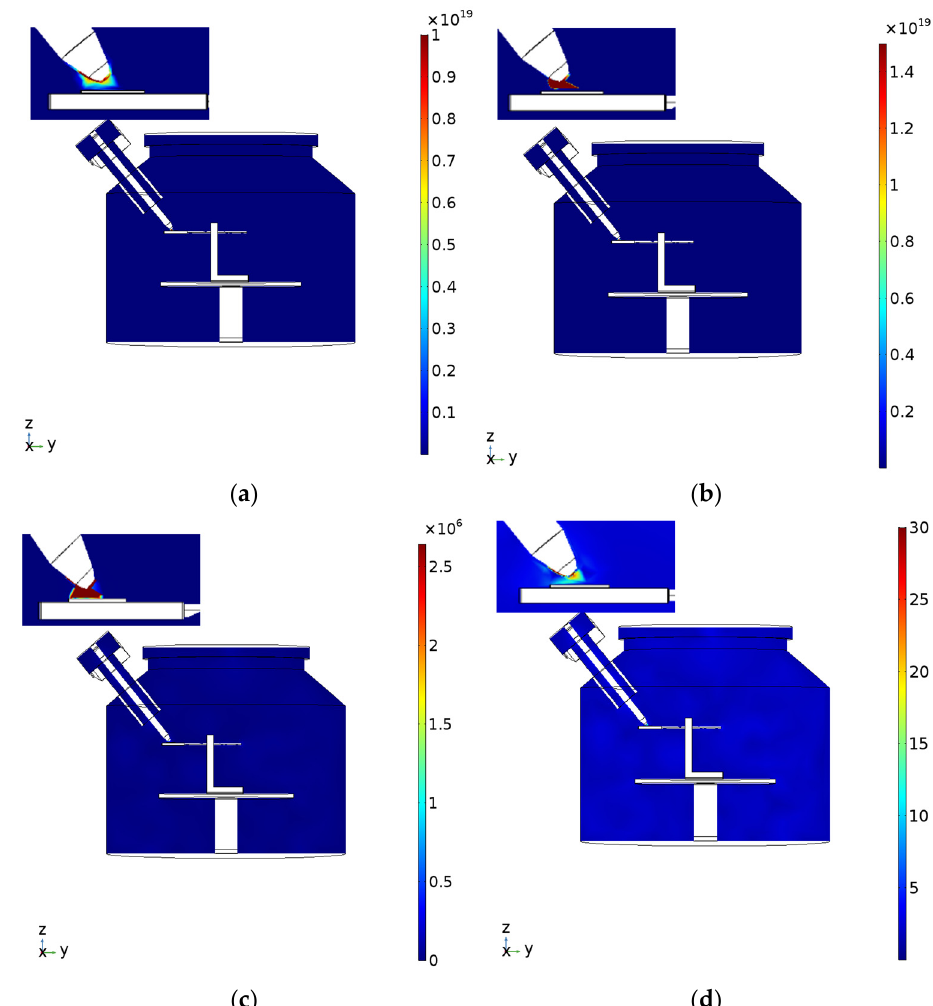
Figure 6. Distribution of ( a ) electron density, ( b ) ion density, ( c ) electric field, and ( d ) electron temperature at the sample holder height of 118 mm, microwave power of 600 W, and argon gas pressure of 70 Torr in the MPJCVD system.